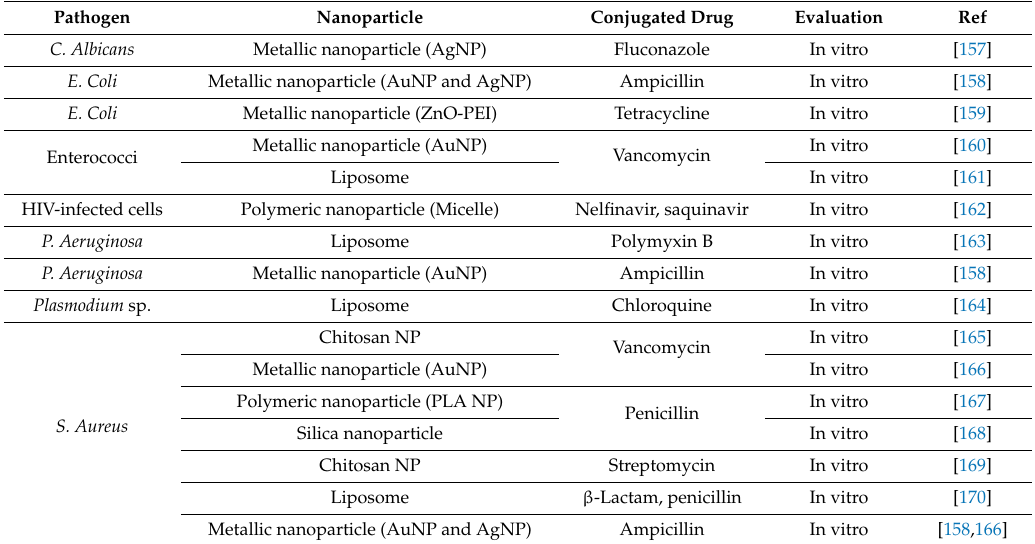
Table 3. Therapeutic nanoparticles and nano-delivery systems for the prevention and treatment of bacterial